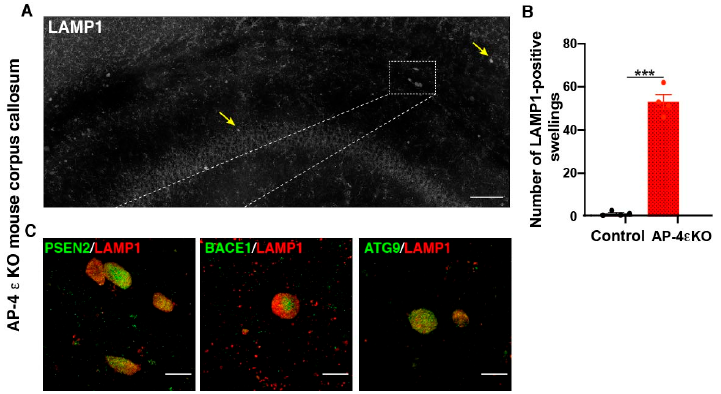
Figure 2. Accumulation of autophagic and lysosomal organelles enriched in APP-processing machinery in dystrophic axons in AP-4 ε KO mice ( A ) Stitched image of a portion of AP-4 ε KO mouse cerebral cortex stained for LAMP1, showing several LAMP1-filled axonal dystrophies in corpus callosum (CC) (yellow arrows; white box). ( B ) Quantification of LAMP1-filled axonal dystrophies in the CC per animal. n = 4 animals per genotype (sex-matched littermate controls were used). ( C ) Enrichment of PSEN2, BACE1, and ATG9 in axonal swellings. Scale bar, 50 μ ( A ) and 10 μ ( C ). ***- ( p < 0.001, unpaired t test)